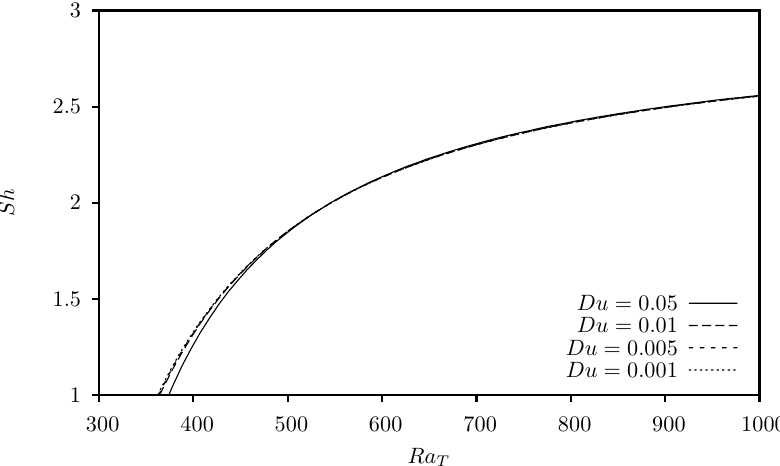
Figure 13. Variation of Sh with Ra T for steady nonlinear stability: effects of Du for Ras = 250, R i = 1, Sr = 0.005, Le =